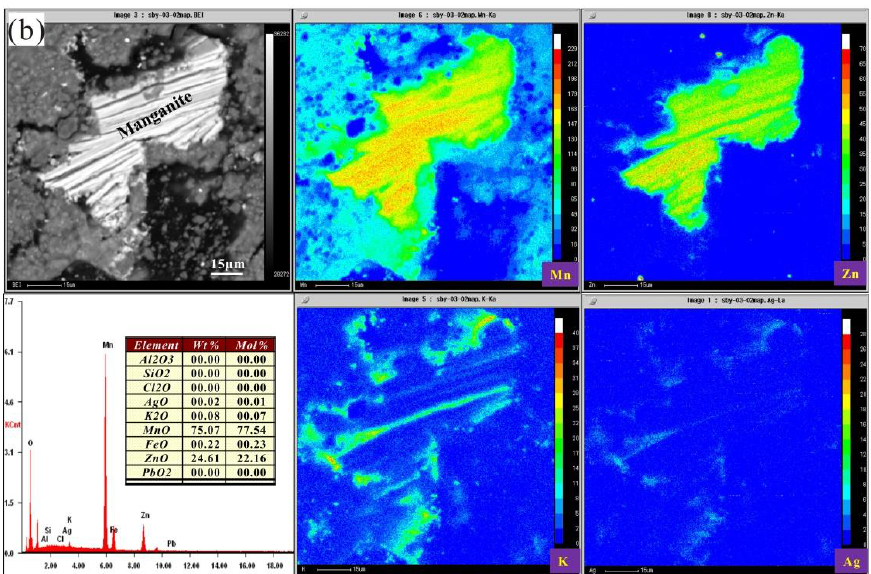
Figure 8 Figure 8. BSE images and the element distributions (WDS, Wavelength Dispersive Spectrometry) of manganite from the Sanbao deposit. ( a ) Manganite with acicular texture often contains high Ag content. Mn and Zn distributions are consistent. Ag distribution is consistent with K distribution. ( b ) Manganite with short columnar texture often contains a small amount of silver. Mn and Zn distributions are consistent in the manganite crystal. Ag distributes along the edge of the manganite. The distribution trends of Ag and K are almost the same in the di ff erent types of